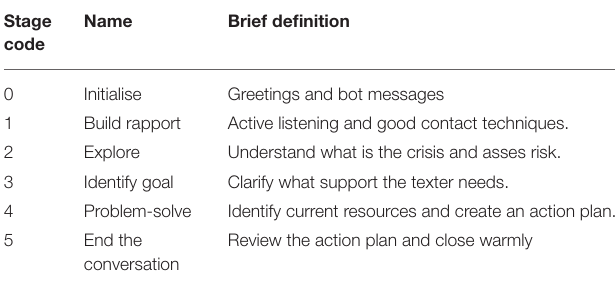
TABLE 1 | Pre-defined conversation stages which Shout Volunteers are trained to follow to best support the